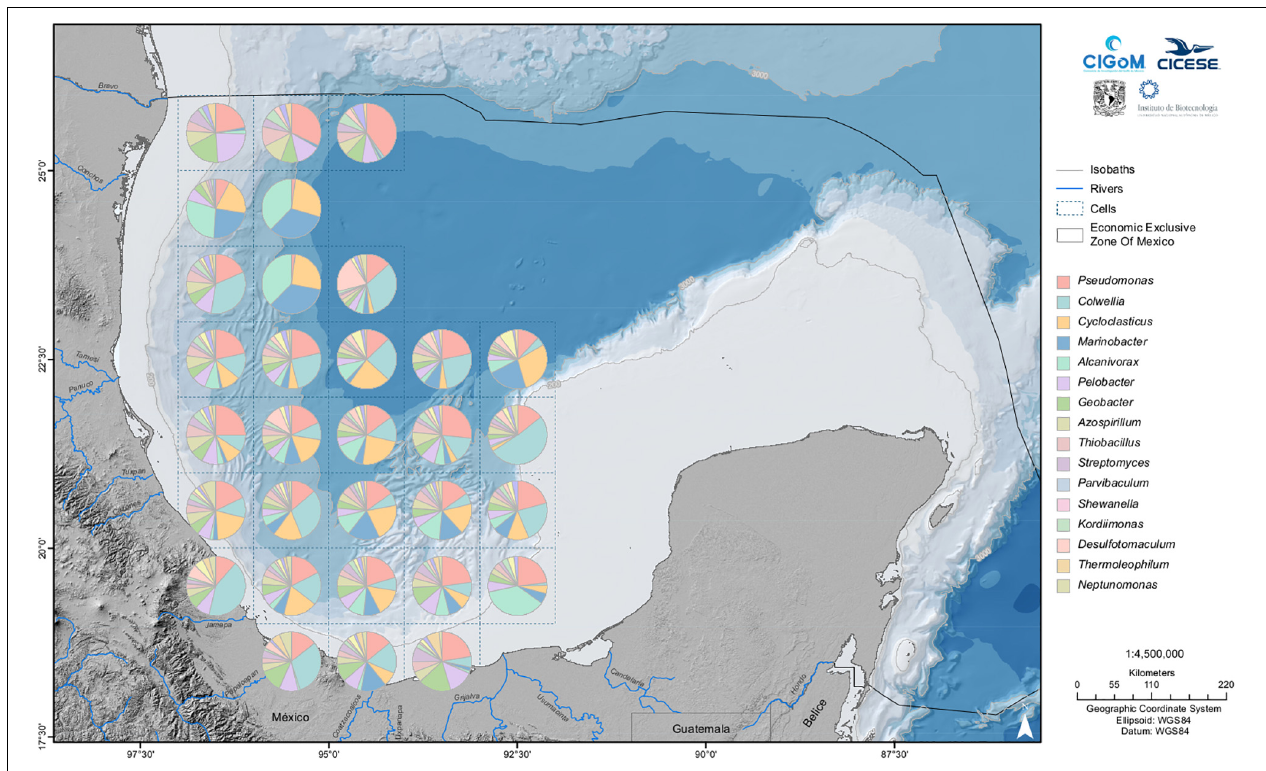
FIGURE 6 | Most abundant genera of hydrocarbon-degrading bacteria in the sediments of the Gulf of Mexico. The genera appear in the legend according to their relative